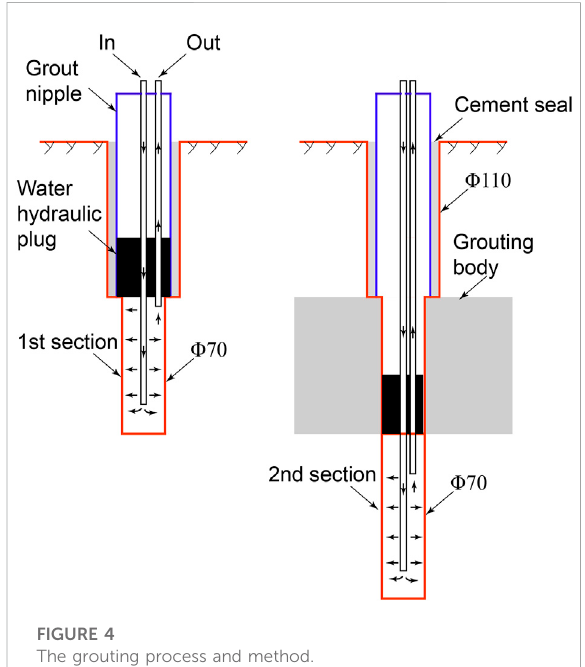
FIGURE 4 The grouting process and method.